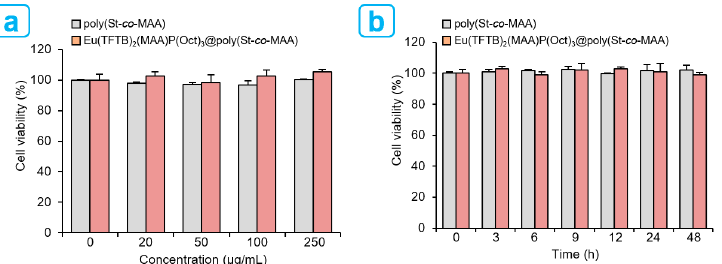
Figure 8. Cell viability of HepG2 cells treated with poly(St-co-MAA) and Eu(TFTB) 2 (MAA)P(Oct) 3 @poly(St-co-MAA) by WST-8 assay. ( a ) Concentration-dependent cell viability of HepG2 cells treated with control and 20, 50, 100 and 250 μ g/mL of poly(St-co-MAA) and Eu(TFTB) 2 (MAA)P(Oct) 3 @poly(St-co-MAA) dispersed in PBS for 24 h. ( b ) Time-dependent cell viability of HepG2 cells treated with 100 μ g/mL of poly(St-co-MAA) and Eu(TFTB) 2 (MAA)P(Oct) 3 @poly(St-co-MAA) for different incubation times of 0, 3, 6, 9, 12, 24 and 48 h.